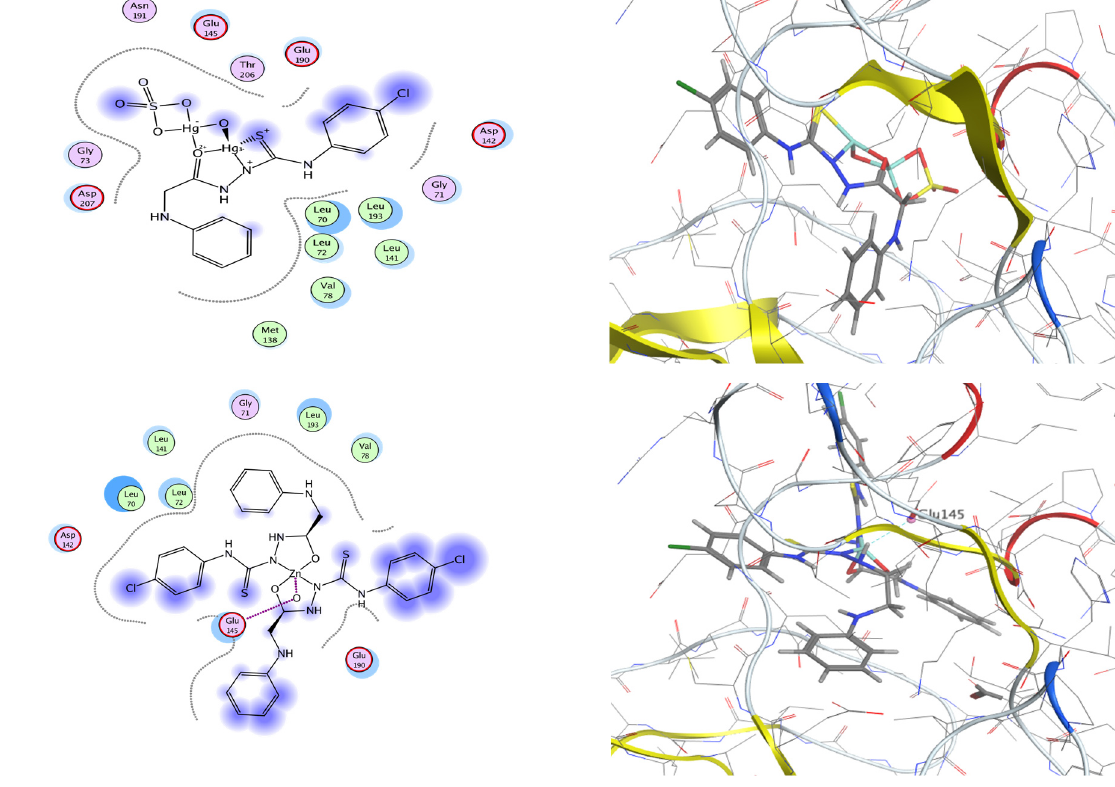
Figure 9. Binding pose of ligand (B) and the Pb(II), Mn(II), Hg(II), and Zn(II) complexes in the active pocket of mitogen- activated kinase (MK-2) (PDB ID: 3WI6).